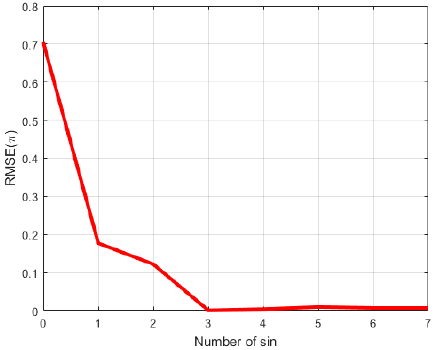
Figure A2. Root Mean Square Errors (RMSEs) of the matching results for rotational motion.